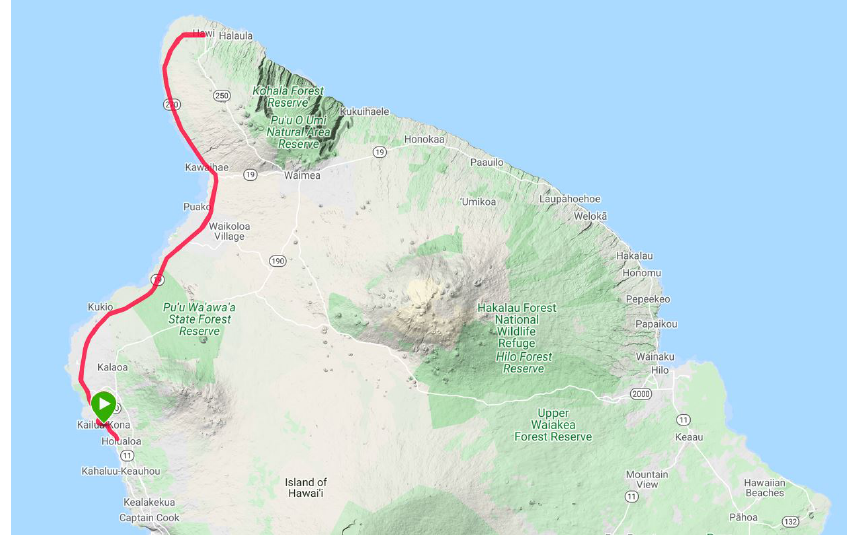
Figure 8. IM Hawaii course map overall. Scale: approximately